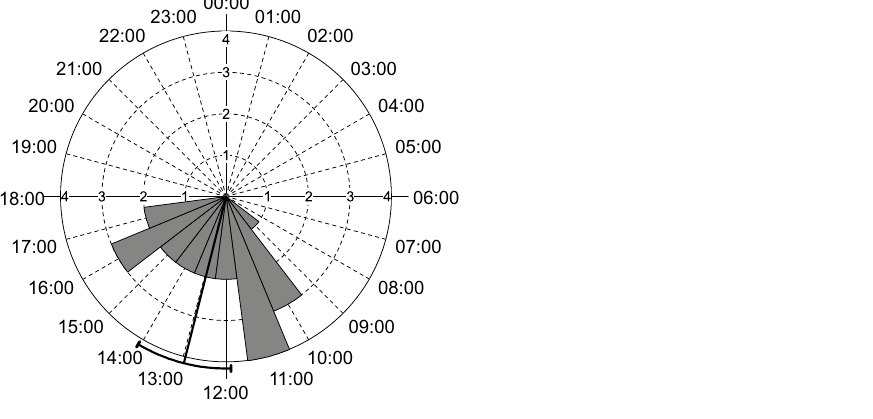
Figure 3. Circular histogram (rose diagram) representing the daily activity per 24-h of Liolaemus montanezi , corresponding to November 1, 2017. The bars represent the absolute frequencies of sighted lizards per hour. Vector and arc represent mean and the 95% confidence interval of the activity